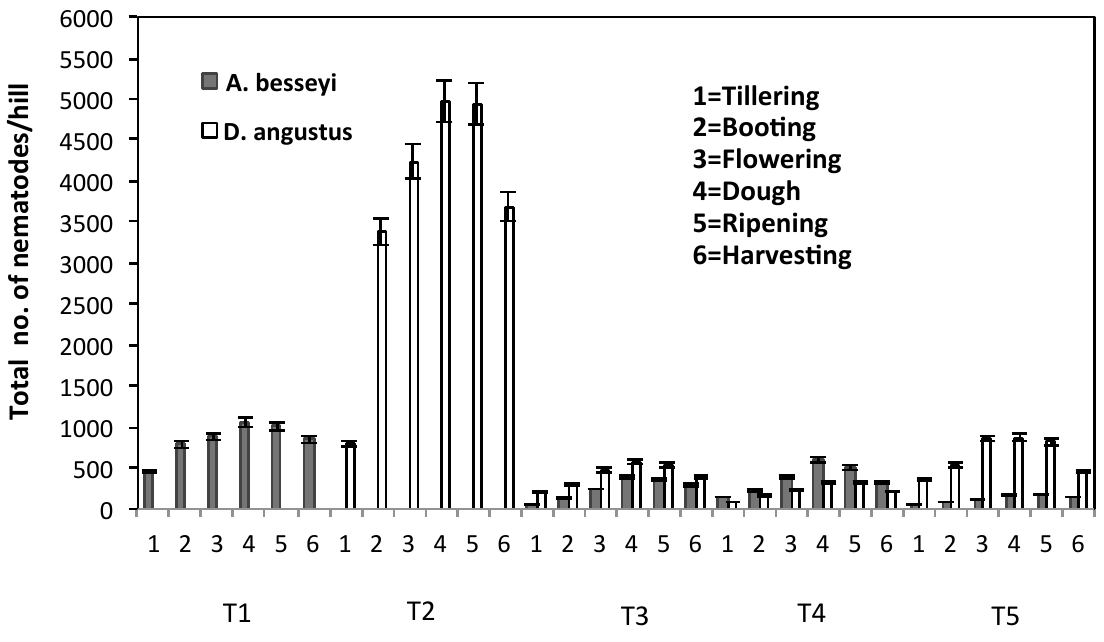
Figure 1A. Population dynamics of Aphelenchoides besseyi and Ditylenchus angustus at different rice plant growth stages in the pot experiment, 2003. Treatments (T), A. besseyi : D. angustus inoculation ratios, T1 = 100:0; T2 = 0:100; T3 = 50:50; T4 = 75:25; T5 = 25:75. Vertical bars indicate standard